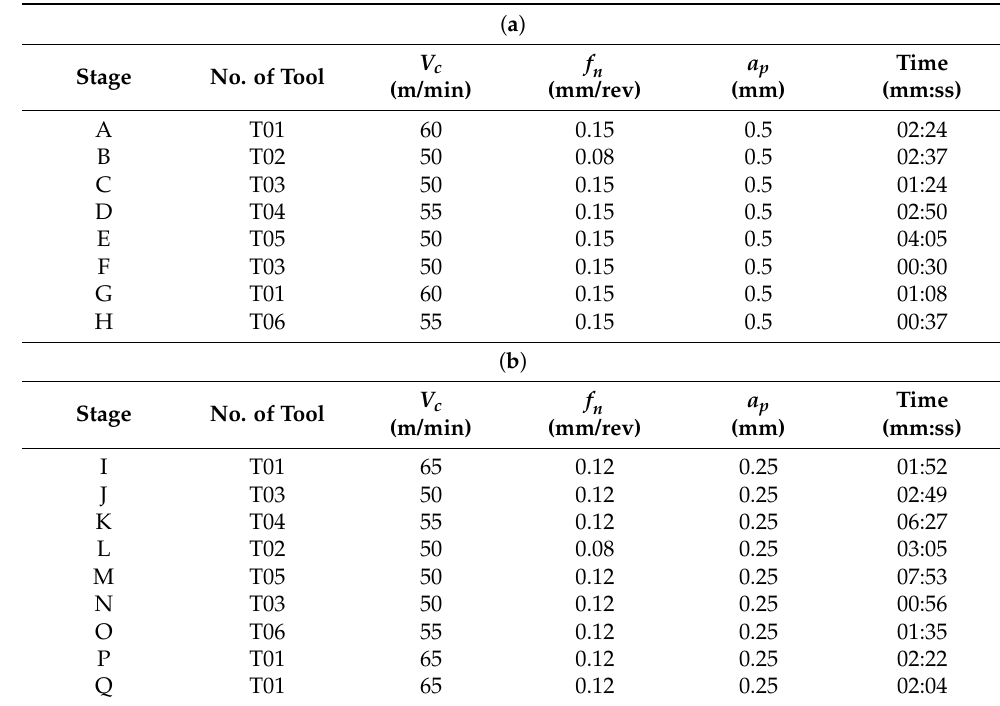
Figure 2. The sample part geometry and stock to be machined. Table 3. The information on cutting conditions and machining time. ( a ) Semi-finishing; ( b ) finishing.